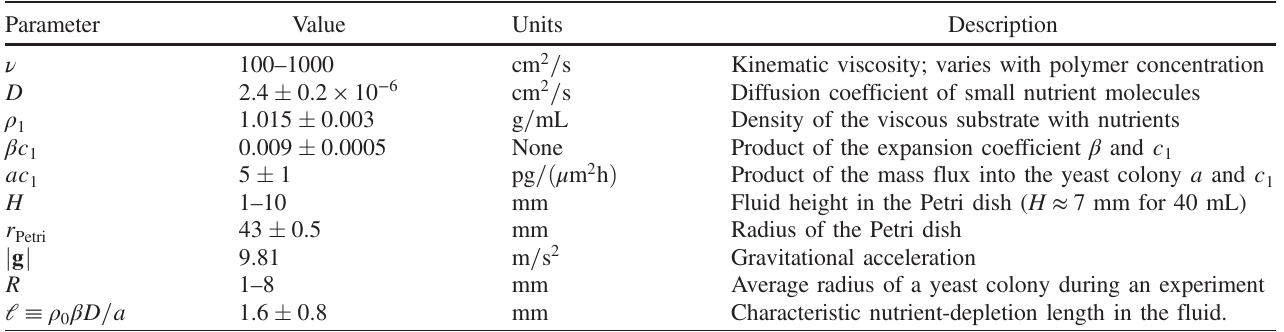
TABLE II. Model parameters and their experimentally measured values, where appropriate. For additional details, see Appendix D. Unless otherwise indicated, the error bars correspond to the standard deviation.